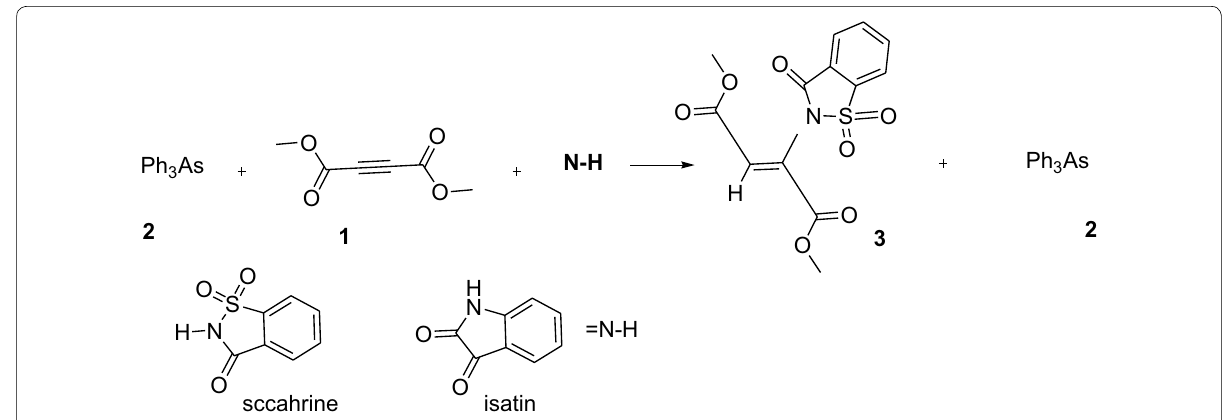
Fig. 1 The three‑component synthesis of a N‑vinylheterocyclic compound [19]